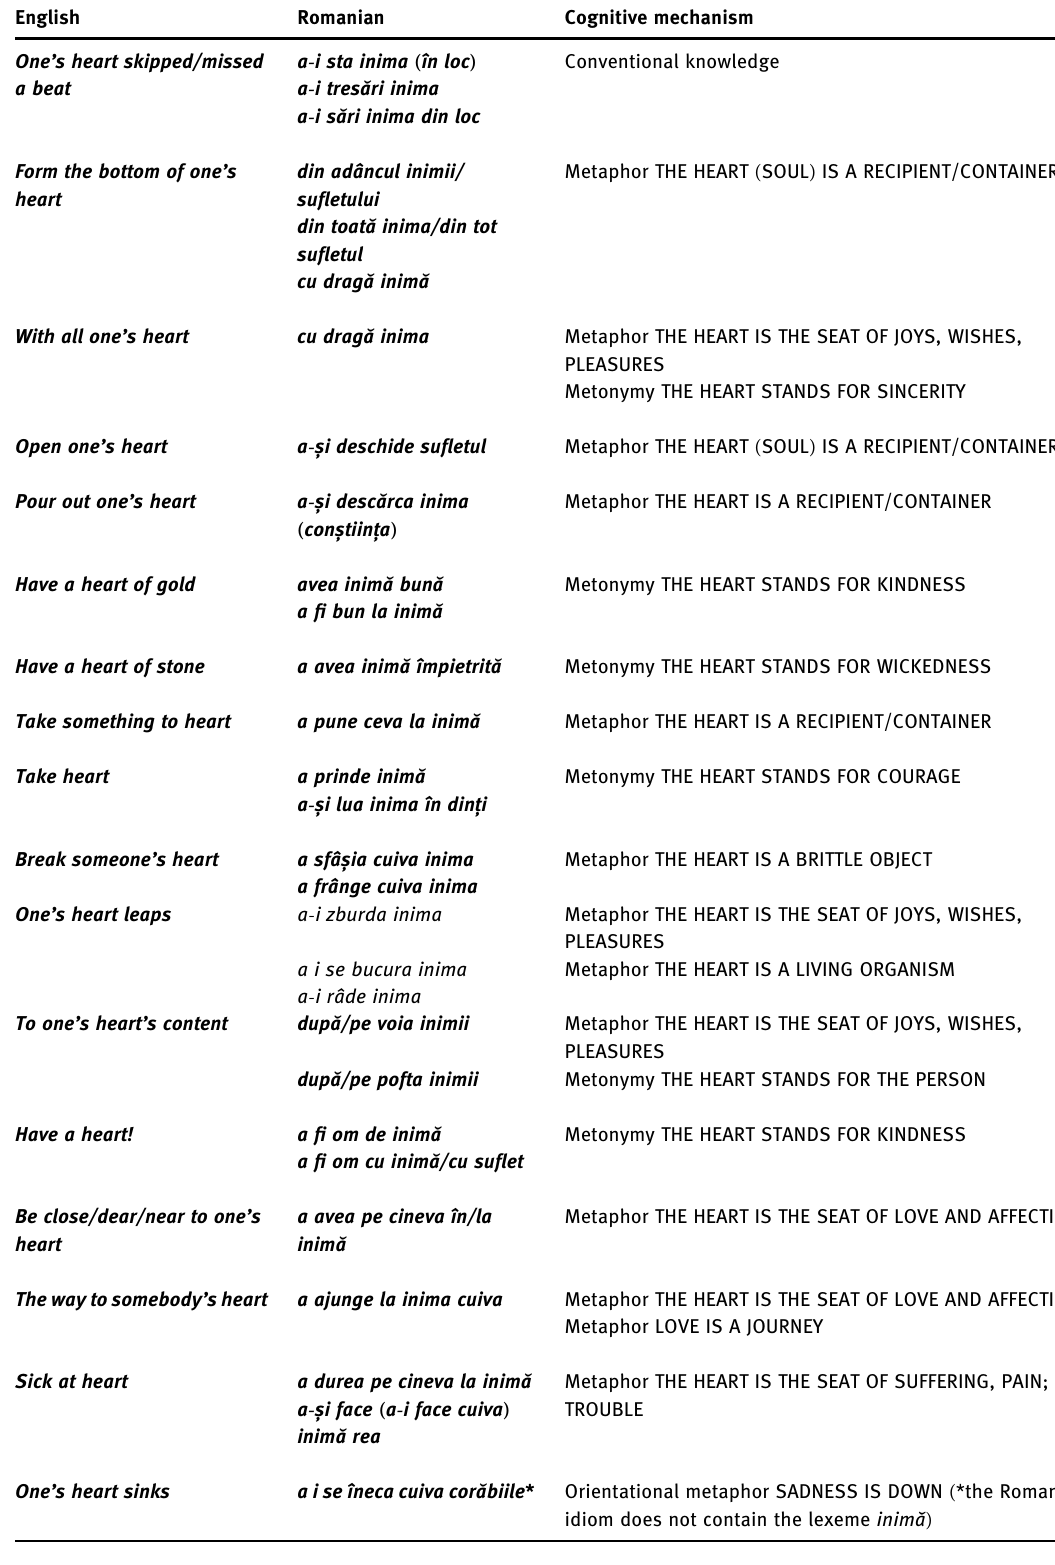
Table 2: English heart idioms and their Romanian equivalents of similar meaning but dissimilar form English Romanian Cognitive